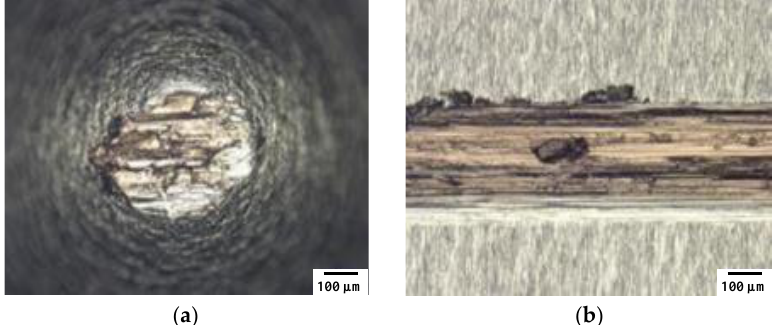
Figure 4. Micrographs of the worn surfaces of a ( a ) the embossed specimen and ( b ) the plate specimen ( t = 0.2 mm, Ag plating 1 µ m, v = 100 mm/min, n = 50).